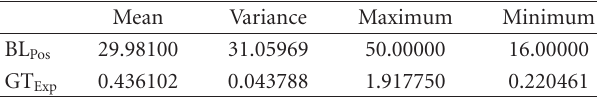
Table 2: BL Pos (cells) and GT Exp ( μ sec) for BL Pos / GT Exp tra ffi c